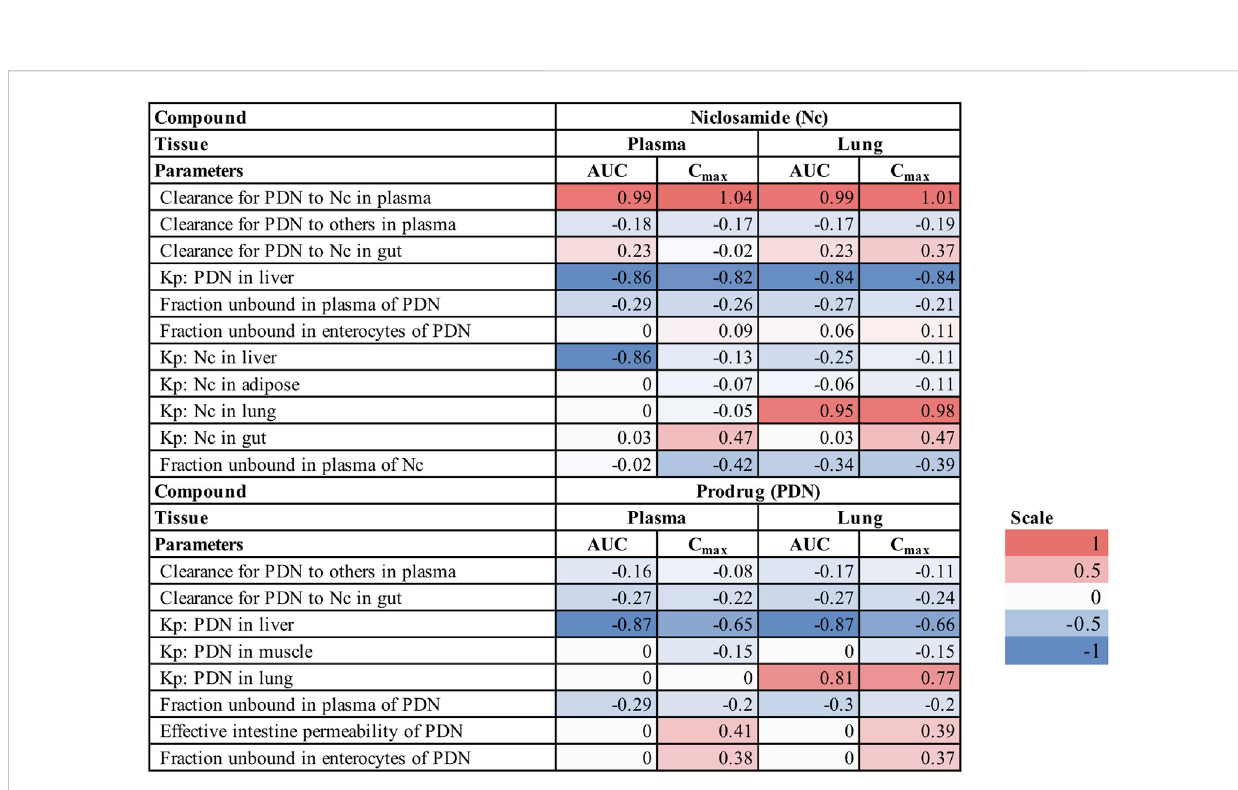
FIGURE 6 Sensitivity coef fi cient (SC) of PBPK model parameters for plasma and lung pro fi les in humans (Only parameters with SC higher than 0.1 or lower than − 0.1 are shown).